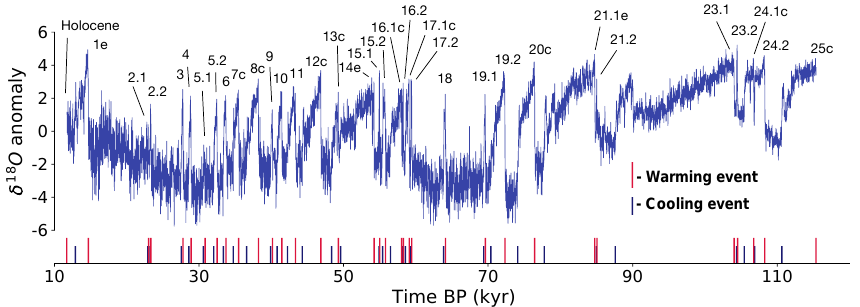
Figure 1. NGRIP oxygen isotope ice core record in 20-year binned resolution and associated Dansgaard–Oeschger warming and cooling events. The numbers above the time series indicate the warming transitions into the respective Greenland interstadials. The nomenclature is adopted from Rasmussen et al. (2014), and only events considered in this study are marked. On the time axis we marked the timing of warming (red) and cooling (blue)